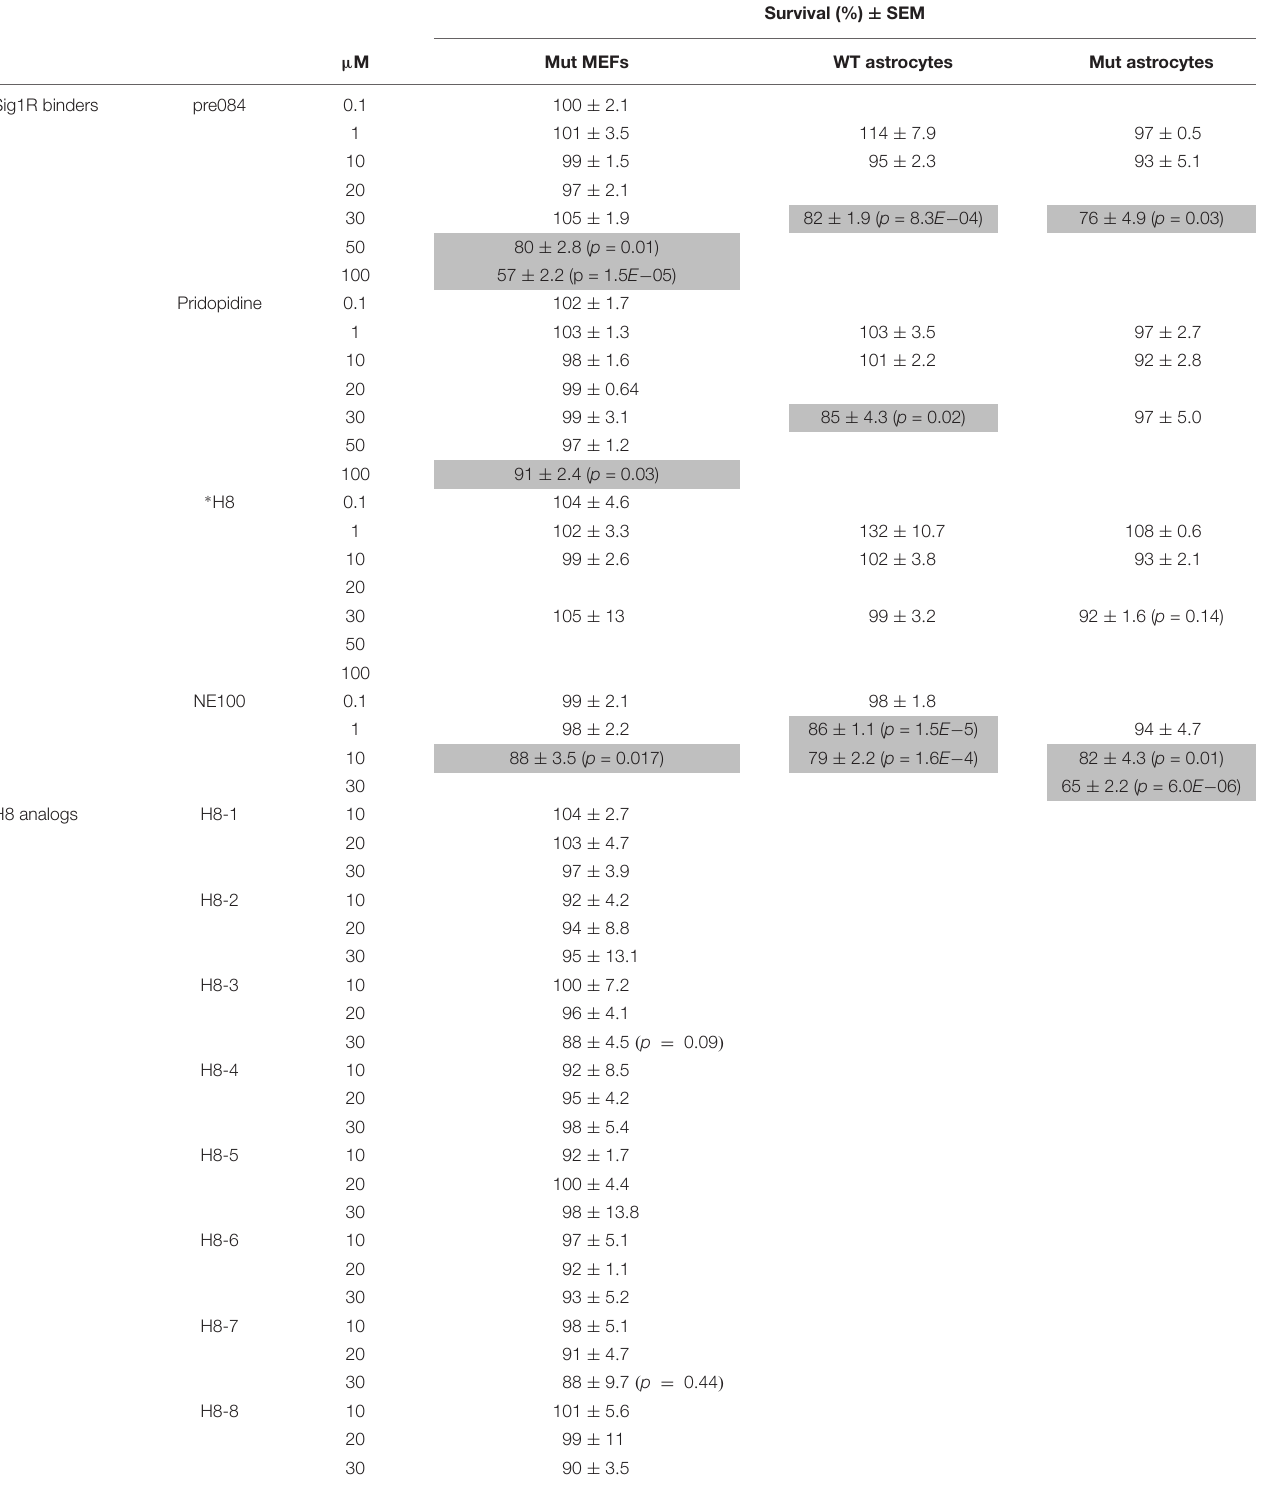
TABLE 3 | Effect of compounds on cell